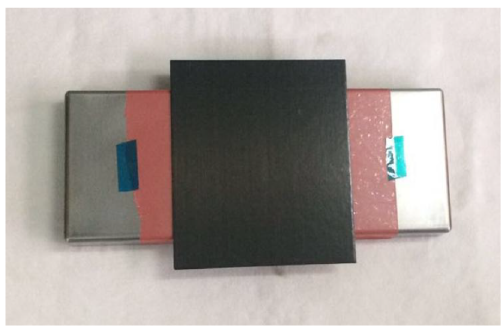
Figure 14. Prepregs and